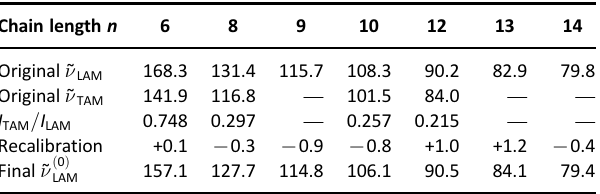
Table 1. Deperturbed and recalibrated LAM-1 wavenumbers of perfluoro- n -alkanes, see text. Wavenumbers and recalibration are given in cm (cid:1) 1